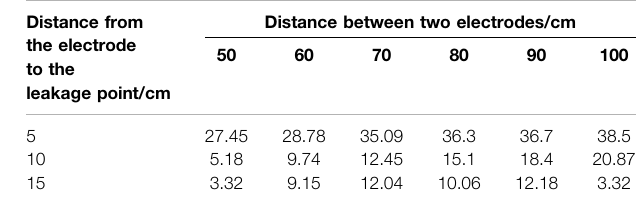
TABLE 1 | Step voltage obtained by the